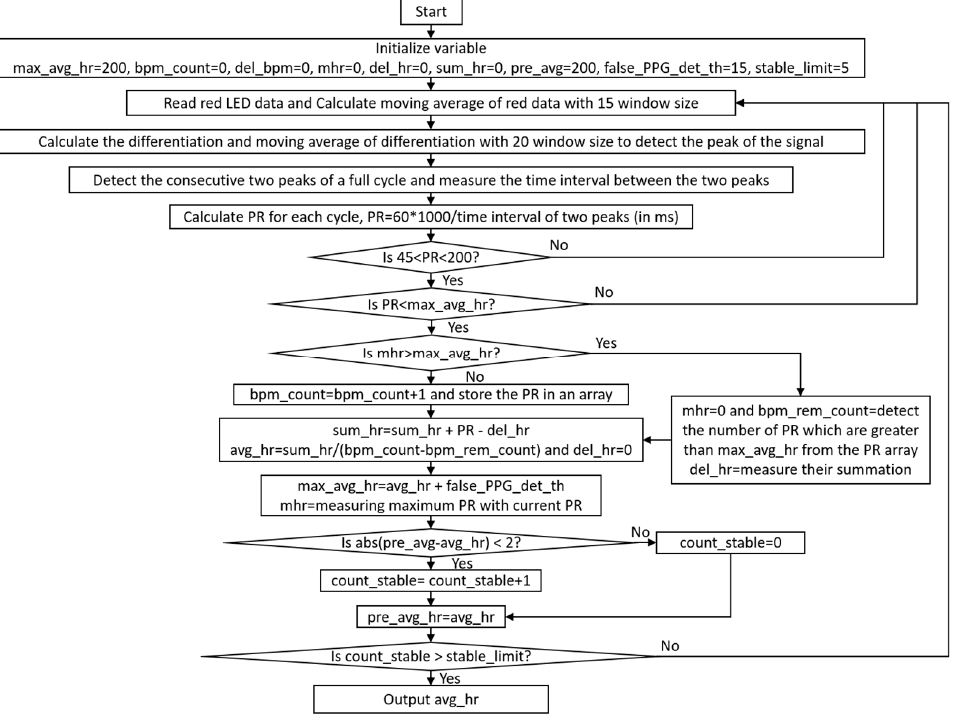
Figure 10. Flow chart of PR measurement with false PPG signal detection.